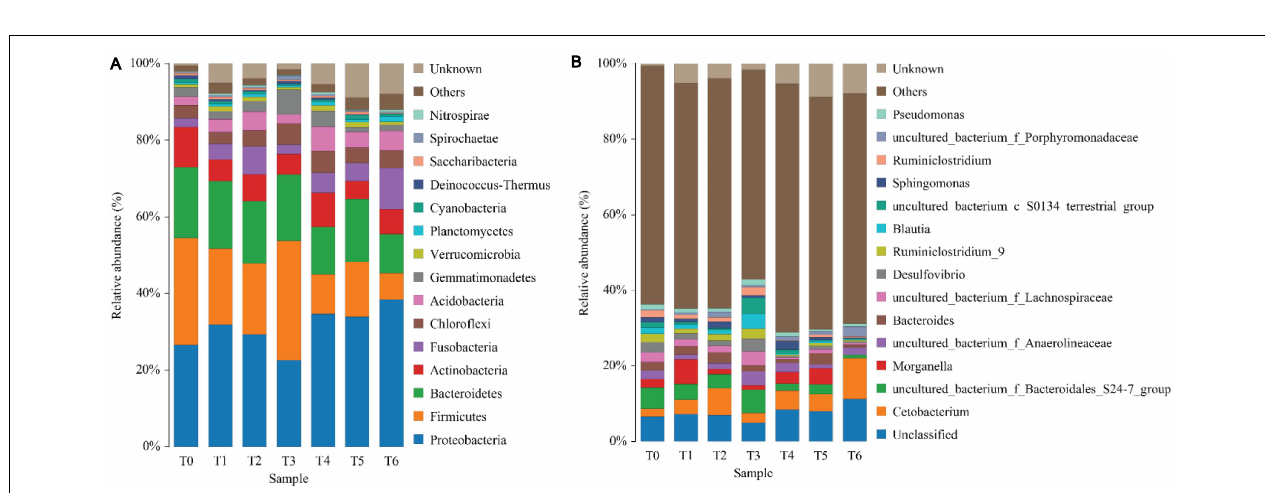
FIGURE 2 | H&E stained anterior intestine morphological sections of E. coioides fed the experimental diets for 56 days (100 × ).